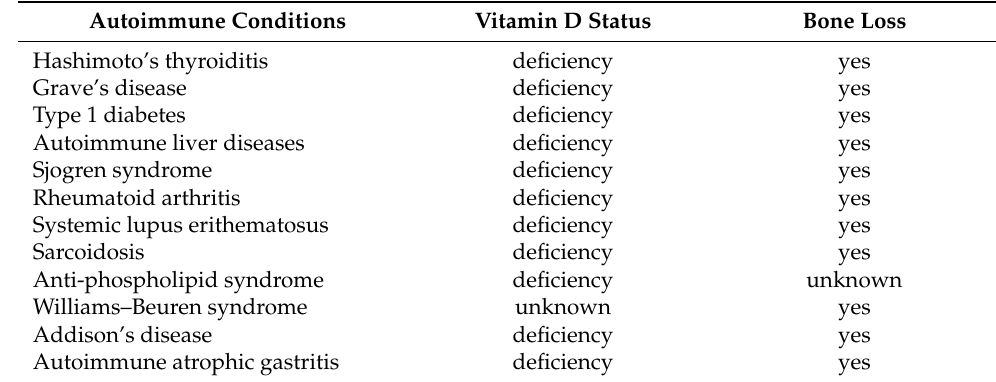
Table 1. Autoimmune conditions associated with CD and considered at risk of